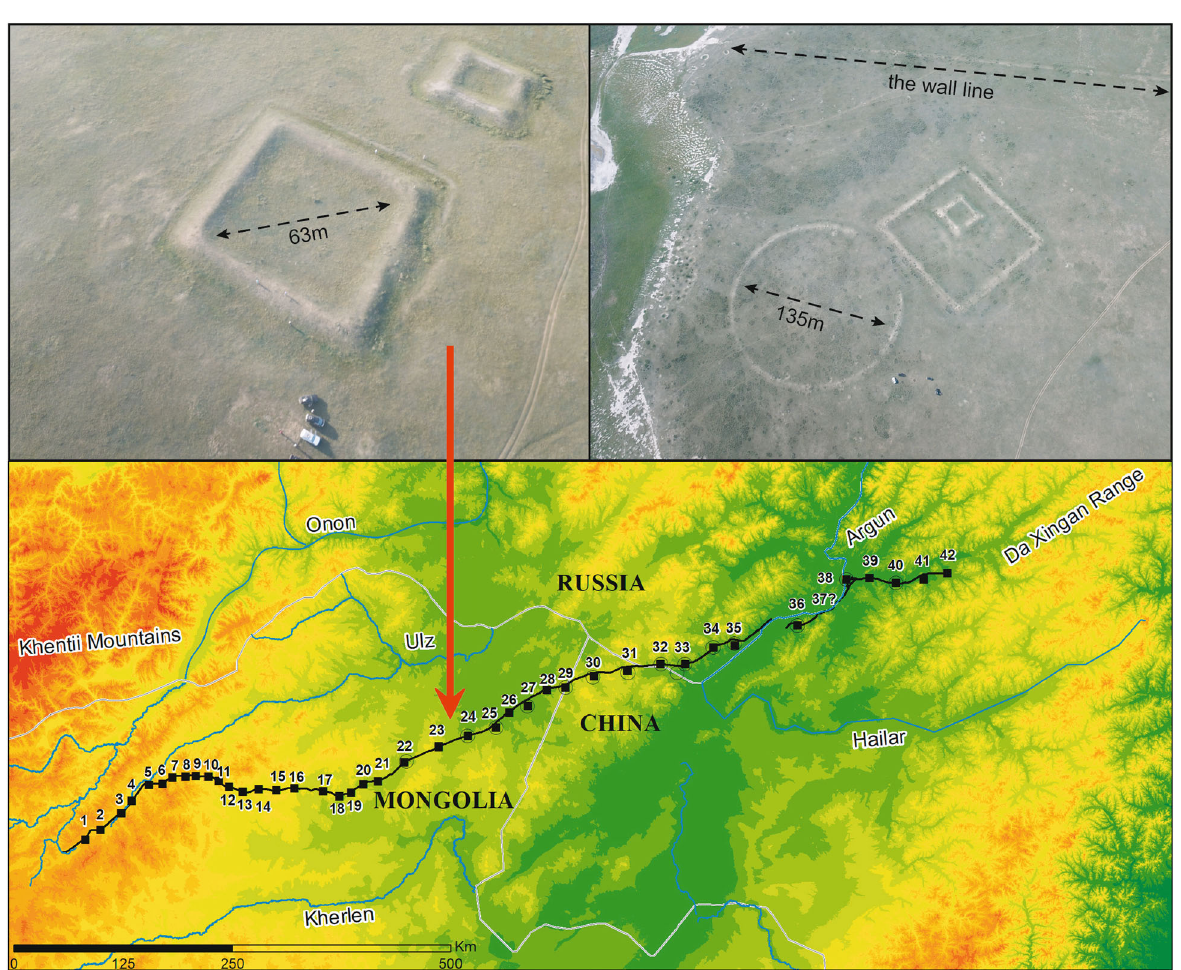
Fig. 2 Structures in Clusters no. 23 (right) and no. 24 (left). (drone photos by Nachem Doron) and their location on the wall line.